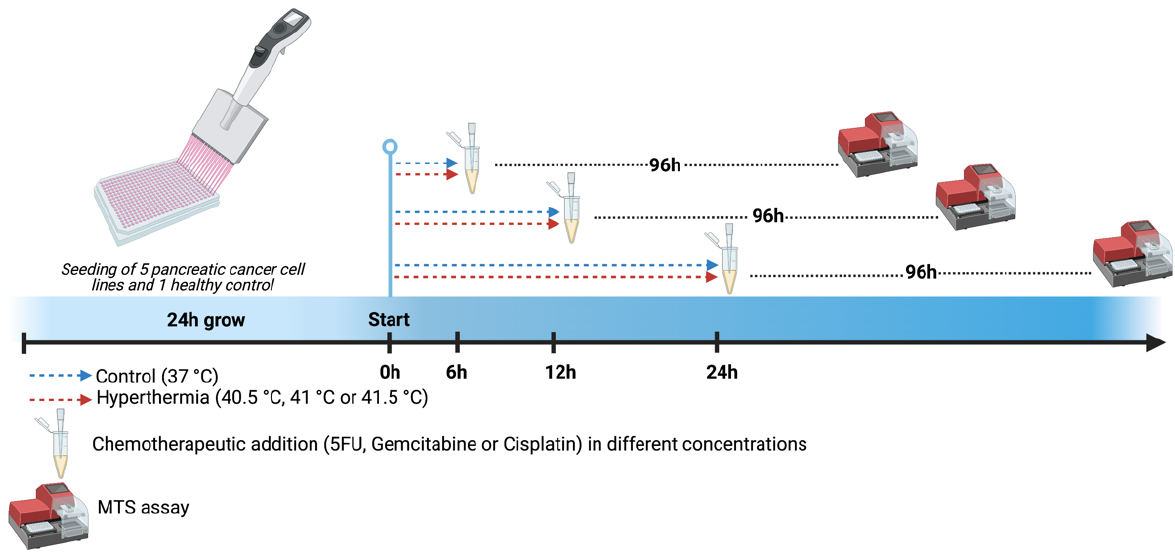
Figure 1. Experimental design. Pancreatic tumor cell lines (BxPC-3, Capan-1, Capan-2, PANC-1, and MIA-PaCa-2) were seeded and expanded for 24 h. Gemcitabine, 5-fluorouracil, and cisplatin were added immediately after hyperthermia treatment using different temperatures (40.5-, 41-, and 41.5 ◦ C) and durations (6-, 12-, and 24 h). Controls were kept at 37 ◦ C. After 96 h, the influence of chemotherapy and temperature on cell survival was determined by MTS assay. Created with